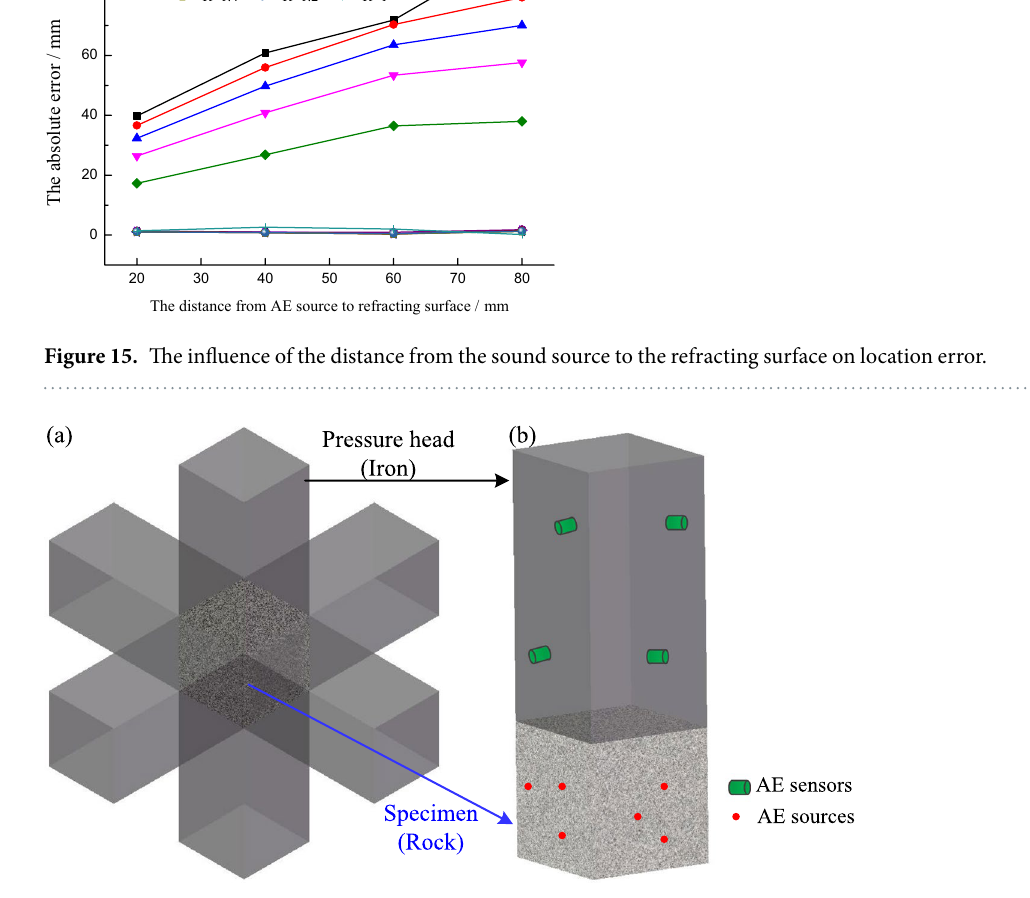
Figure 16. The triaxial compression test of rock. ( a ) The layout of the pressure heads and the specimen. ( b ) The AE source location from the pressure